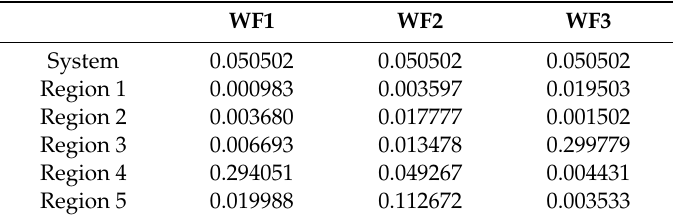
Table 1. The AS of system / regional RoCoF w.r.t the output of individual wind farms (WFs).